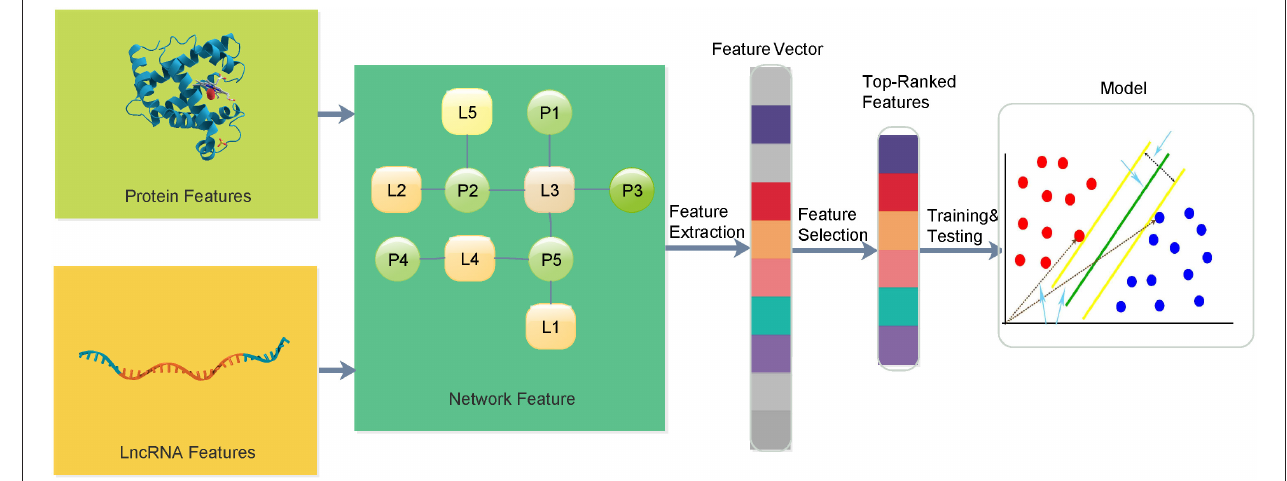
FIGURE 1 | The overall framework of the proposed method for lncRNA–protein interactions.